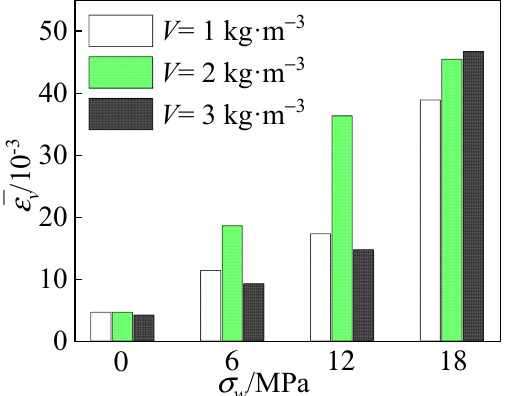
Figure 20. Effect of polypropylene fibers addition on peak strain.